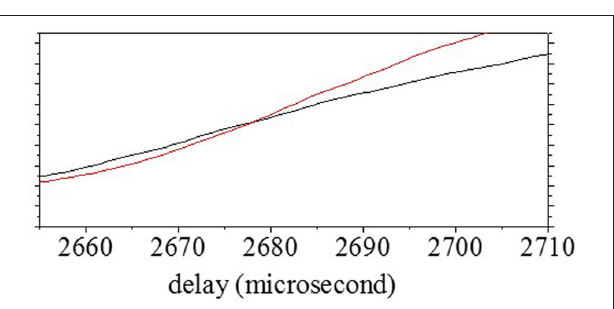
FIGURE 5 | Determination of T 1 . The solid curve shows candidates for the reflected intensity distribution estimated from S echo at onset delay time τ on . The dotted curve shows candidates for the reflected intensity distribution estimated from S echo at 10 μ s after τ on . T 1 was determined by estimating the correspondence between the reflectivity of candidates at each delay